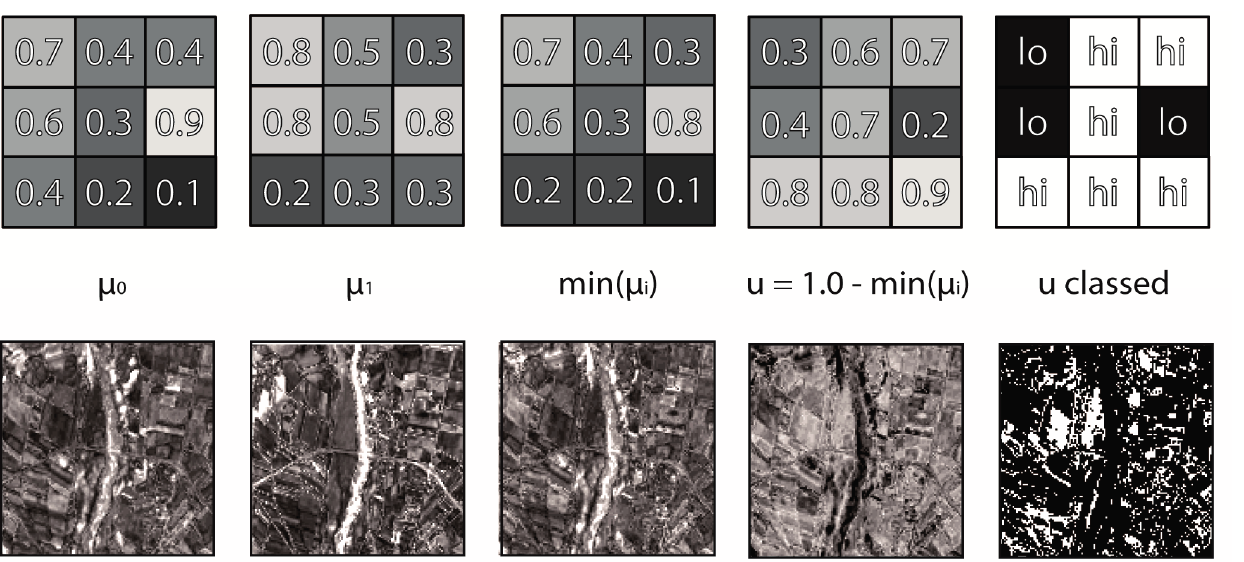
Figure 3. Example for change uncertainty measure (here: per-pixel and bi-temporal). Schematic (top row) and real data example (bottom row). Uncertainty is represented by a grayscale from black (0.0) to white